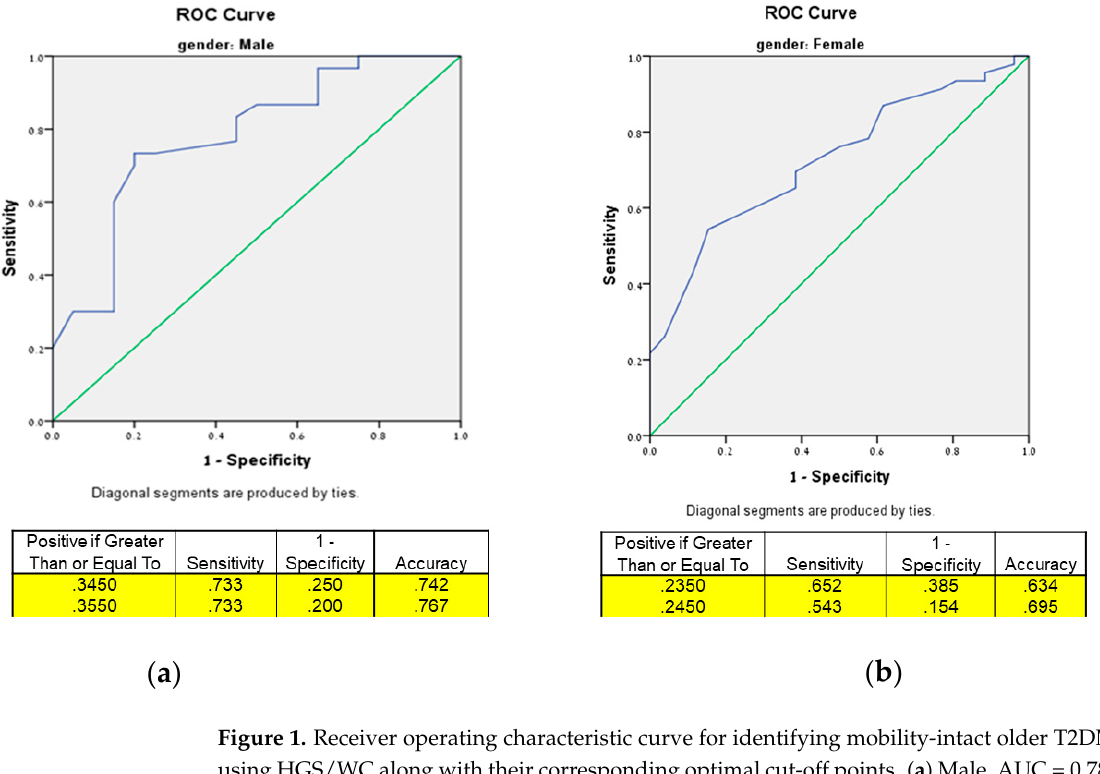
Figure 1. Receiver operating characteristic curve for identifying mobility-intact older T2DM patients using HGS/WC along with their corresponding optimal cut-off points. ( a ) Male, AUC = 0.781 (95% CI 0.649–0.913); ( b ) female, AUC = 0.725, (95% CI 0.609–0.842).